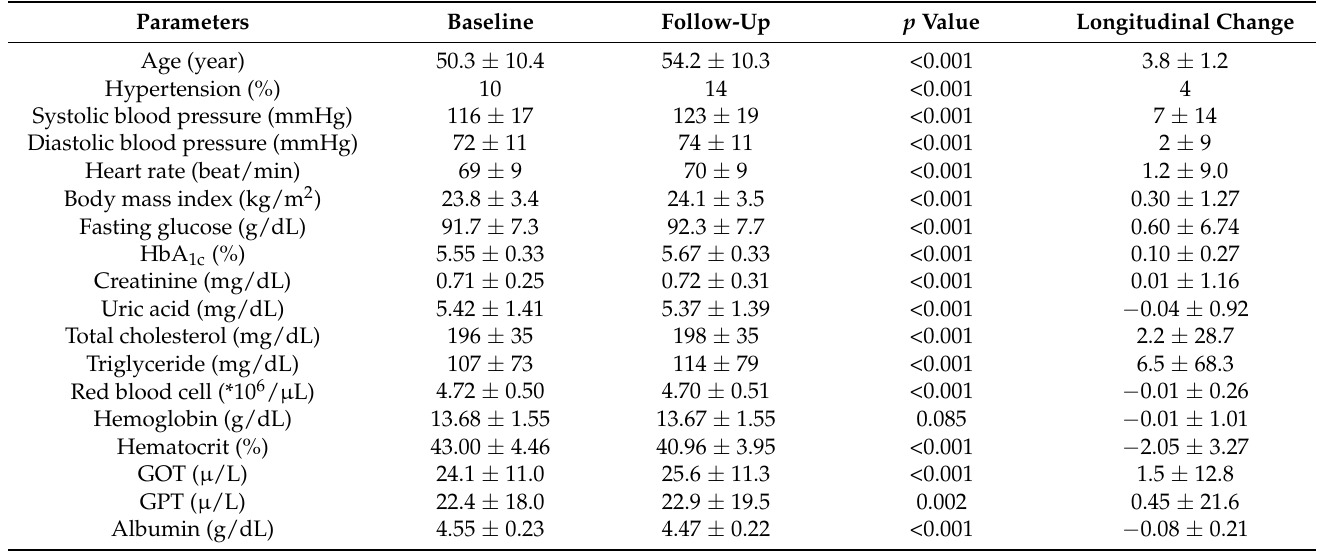
Table 1. Longitudinal changes of clinical and laboratory data during 3.8-year follow-up in 23,326 study subjects.